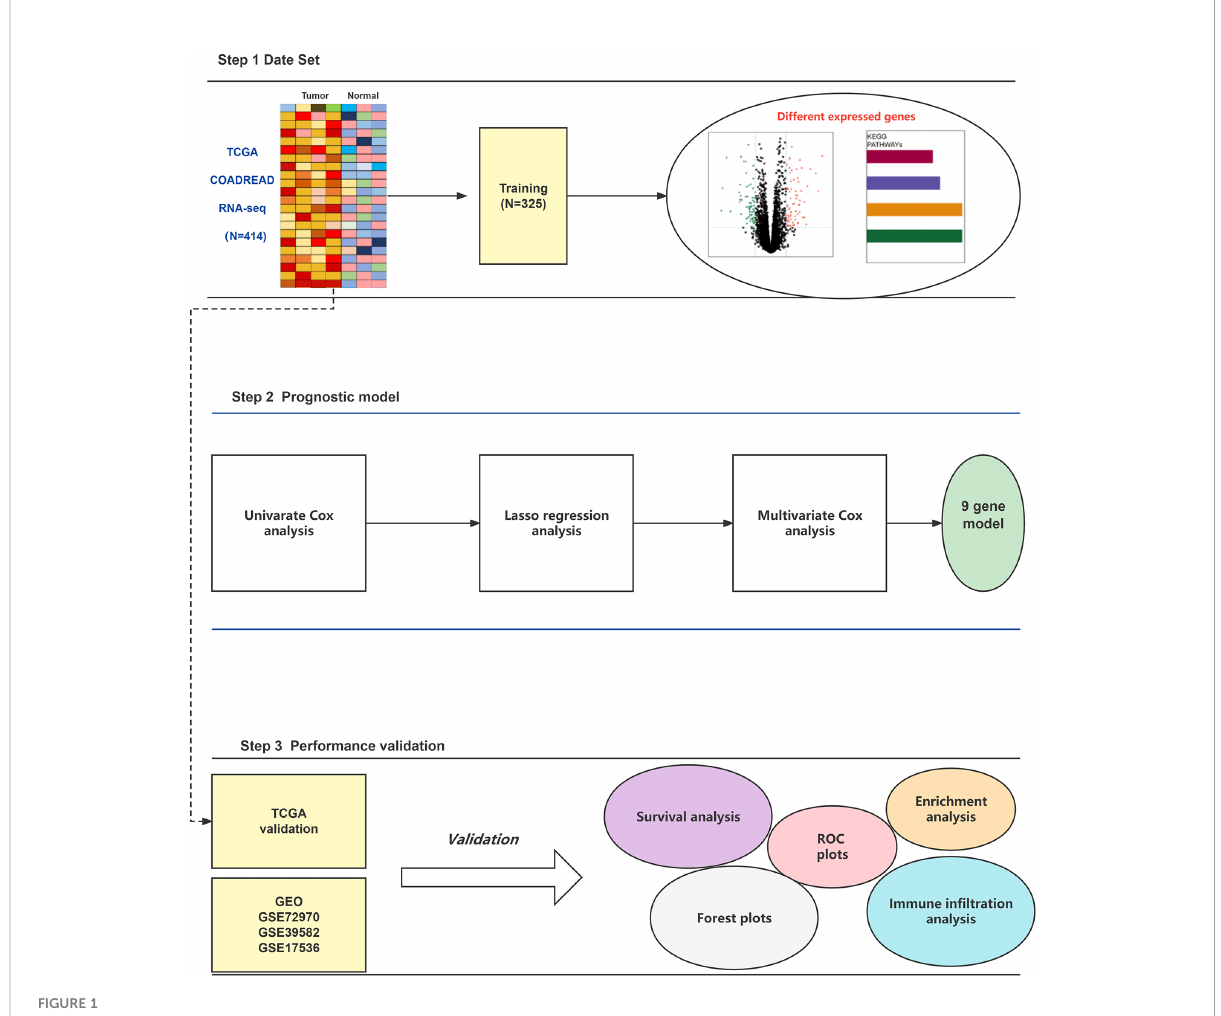
FIGURE 1 The work fl ow of this